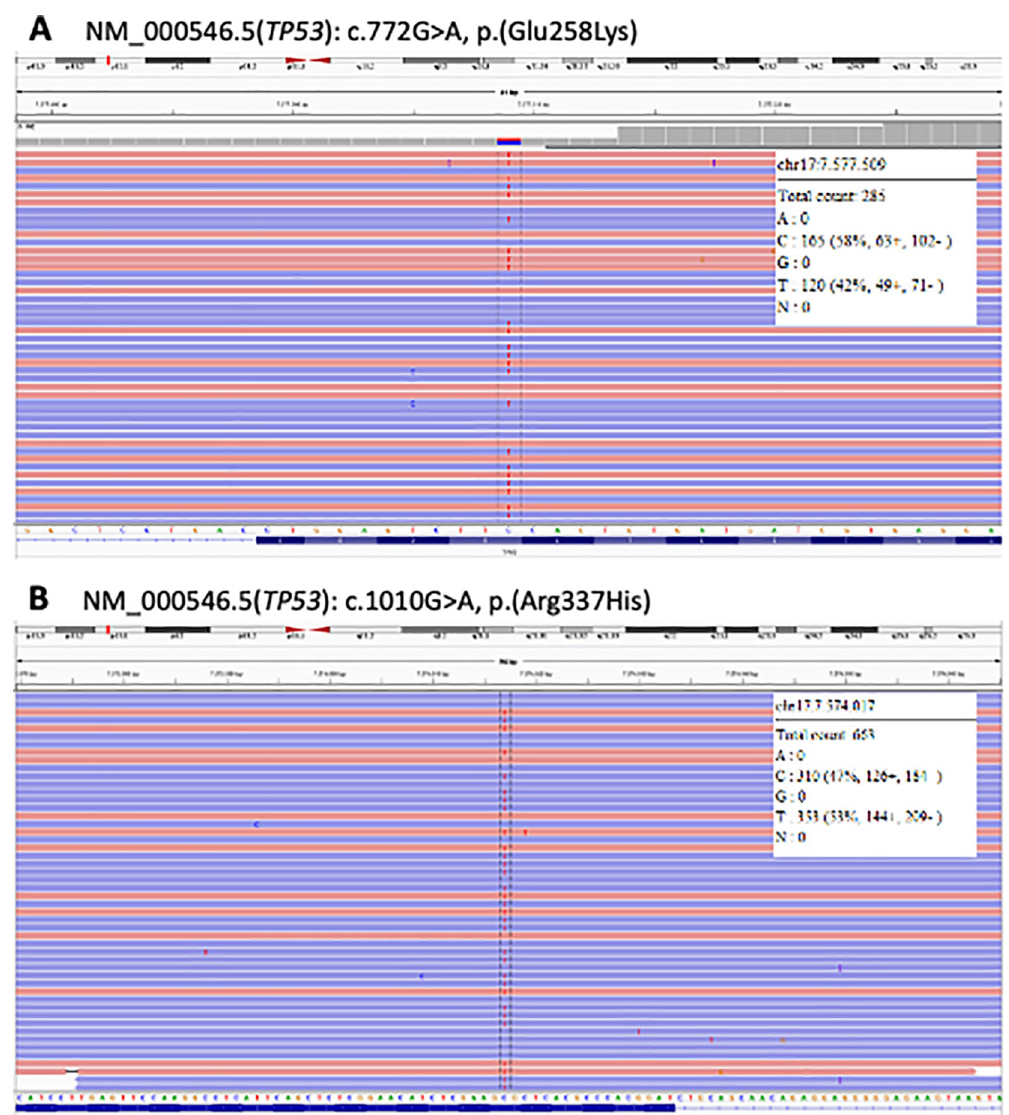
Fig 2. Representative next-generation sequencing results encompassing the TP53 entire coding region (minimum coverage of 100X by amplicon) from two probands fulfilling the 2015 revised Chompret criteria for Li-Fraumeni syndrome. (A) Carrier of a germline pathogenic variant (PV) located in the p53 DNA binding domain (DBD); and (B) carrier of the Brazilian founder R337H PV located in the p53 oligomerization domain. Description of TP53 sequence variants is provided according to updated Human Genome Variation Society (HGVS) recommendations. Human TP53 sequence corresponding to the NM_000546.5 was used as a wild-type reference. Right panels show wild-type and variant allele counts, which were consistent with the expected germline occurrence of these genetic alterations (around 50% of reads for each allele). Note that both alleles were analyzed from antisense strand due to the TP53 gene orientation. Chr17, position or genomic coordinate at chromosome 17 (GRCh37/hg19 human genome